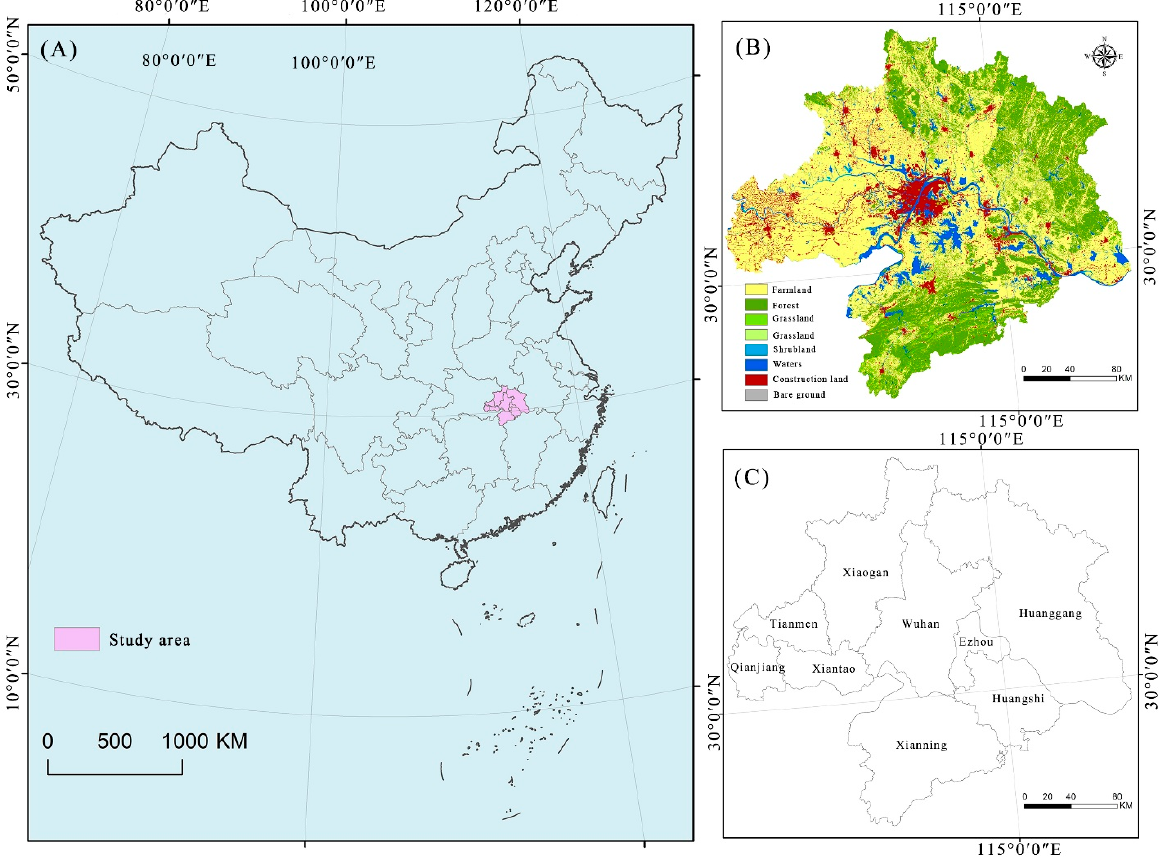
Figure 1. Location of the study area ( A ), land cover ( B ), and administrative division ( C ).